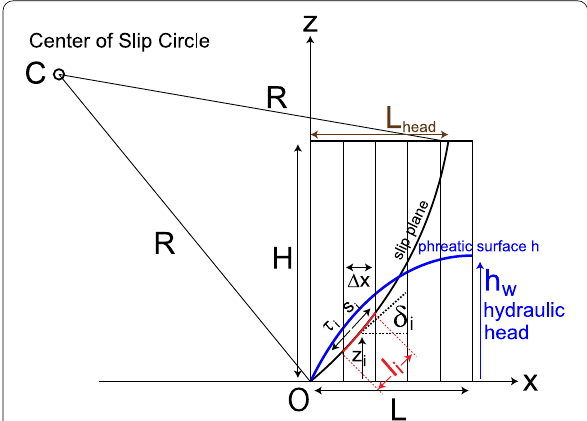
Fig. 13 A schematic diagram showing the geometry of the method of slices used to evaluate cliff stability. The slip plane is circular (center C, radius R), passing through the origin (O). The landslide head length L head is measured from the intercept of the slip circle at the top or rear plane of the cliff. The phreatic surface h ( x ) is parabolic, such that h ( 0 ) = 0 and h ( L ) = h w . Wet sand is saturated (unsaturated) below (above) the h ( x ), and corresponding values of ρ , µ ′ , c ′ are used. (cid:31) x ( = 1.35 mm) is the slice width. z i , l i , and δ i are the height, length, and slope angle of the slip plane, respectively, at the slice number i . s i and τ i are the resisting and disturbing tangential stress, respectively, at the slip